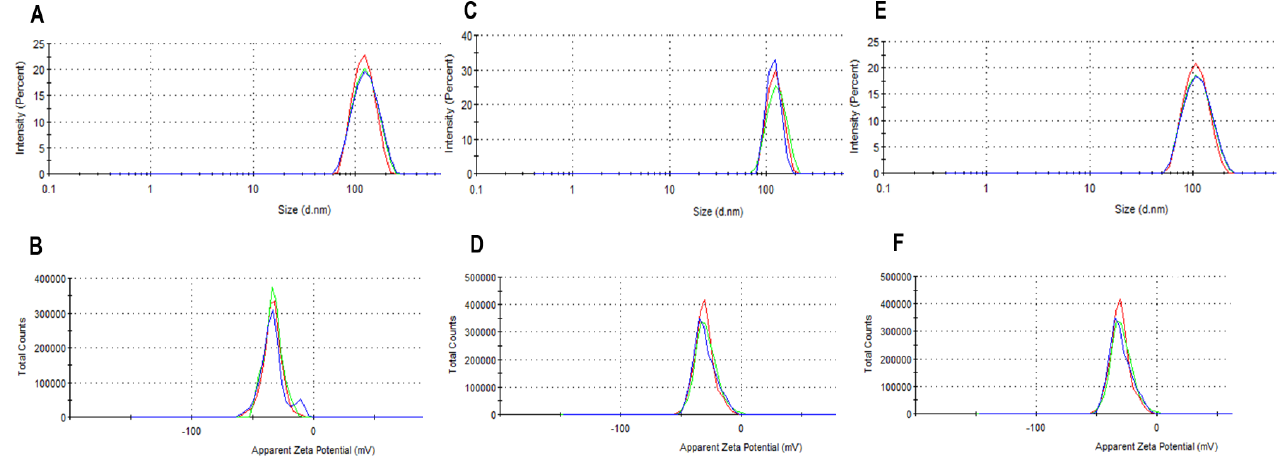
Figure 11. (A , C , E ) represent the size distribution of DOX-LCL, SIM1-DOX-LCL, and SIM2-DOX-LCL, respectively. ( B , D , F ) represent the zeta potential distribution of DOX-LCL, SIM1-DOX-LCL, and SIM2-DOX-LCL, respectively. The measurements were performed in triplicate, and each measurement is represented with a different colour (blue, red, or green).